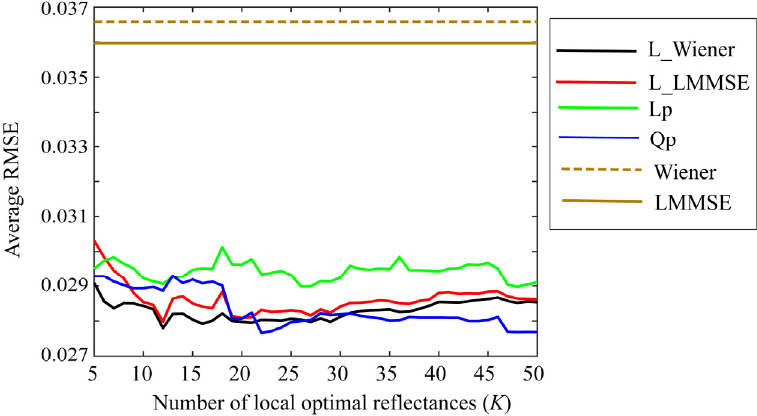
Figure 8. Average RMSEs obtained by the proposed methods for 24 color checkers in the range of small K of 5–50 when applying the methods to image data acquired using Apple iPhone 8.